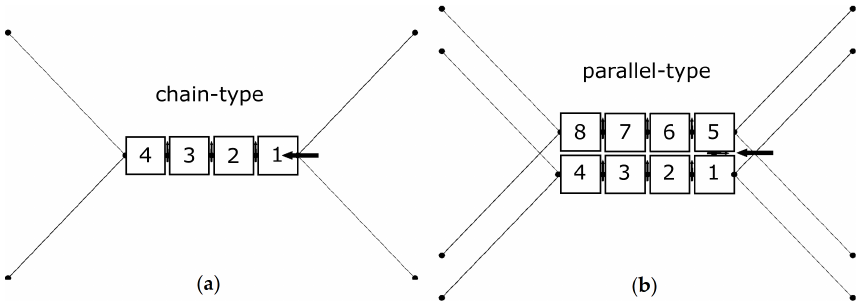
Figure 16. Layouts of the test cases for studying the sensitivity to module arrangement: ( a ) the chain configuration; ( b ) and the parallel